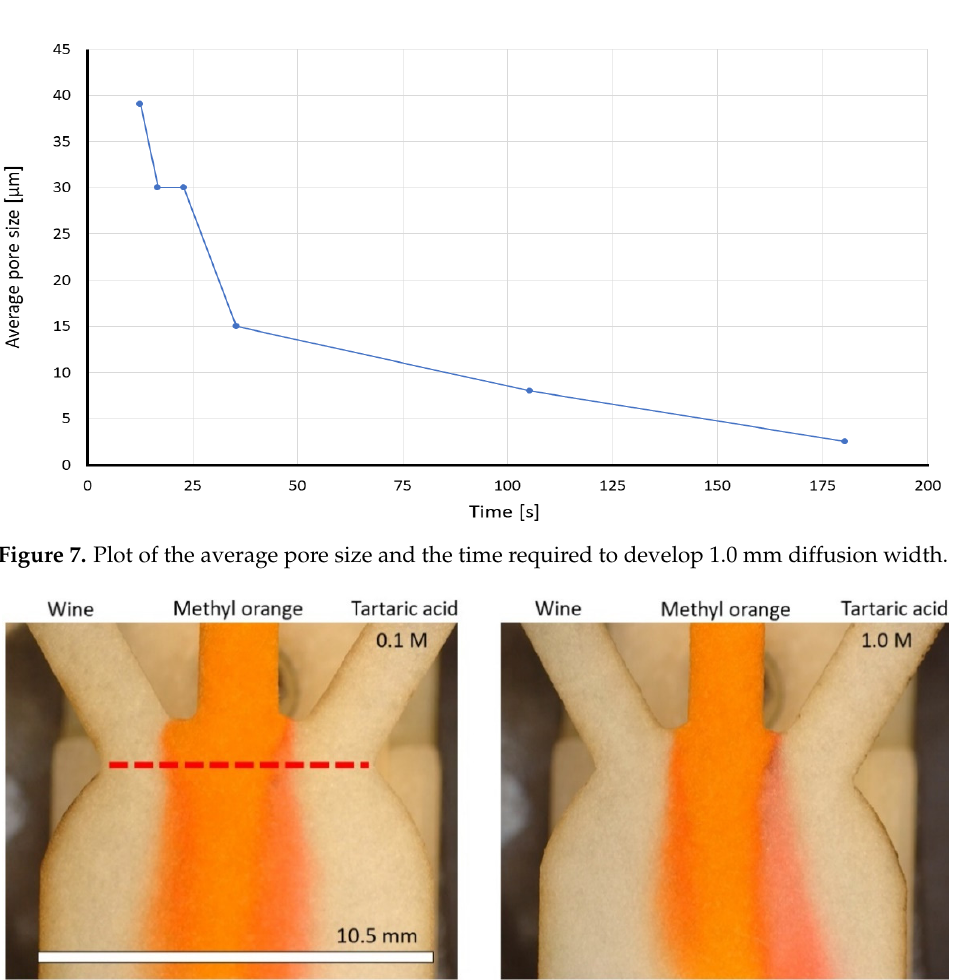
the “Time zero” for ( a ) 0.1 M and ( b ) 1.0 M of tartaric acid. The measurement line is shown as the dashed line with 7.5 mm of width.